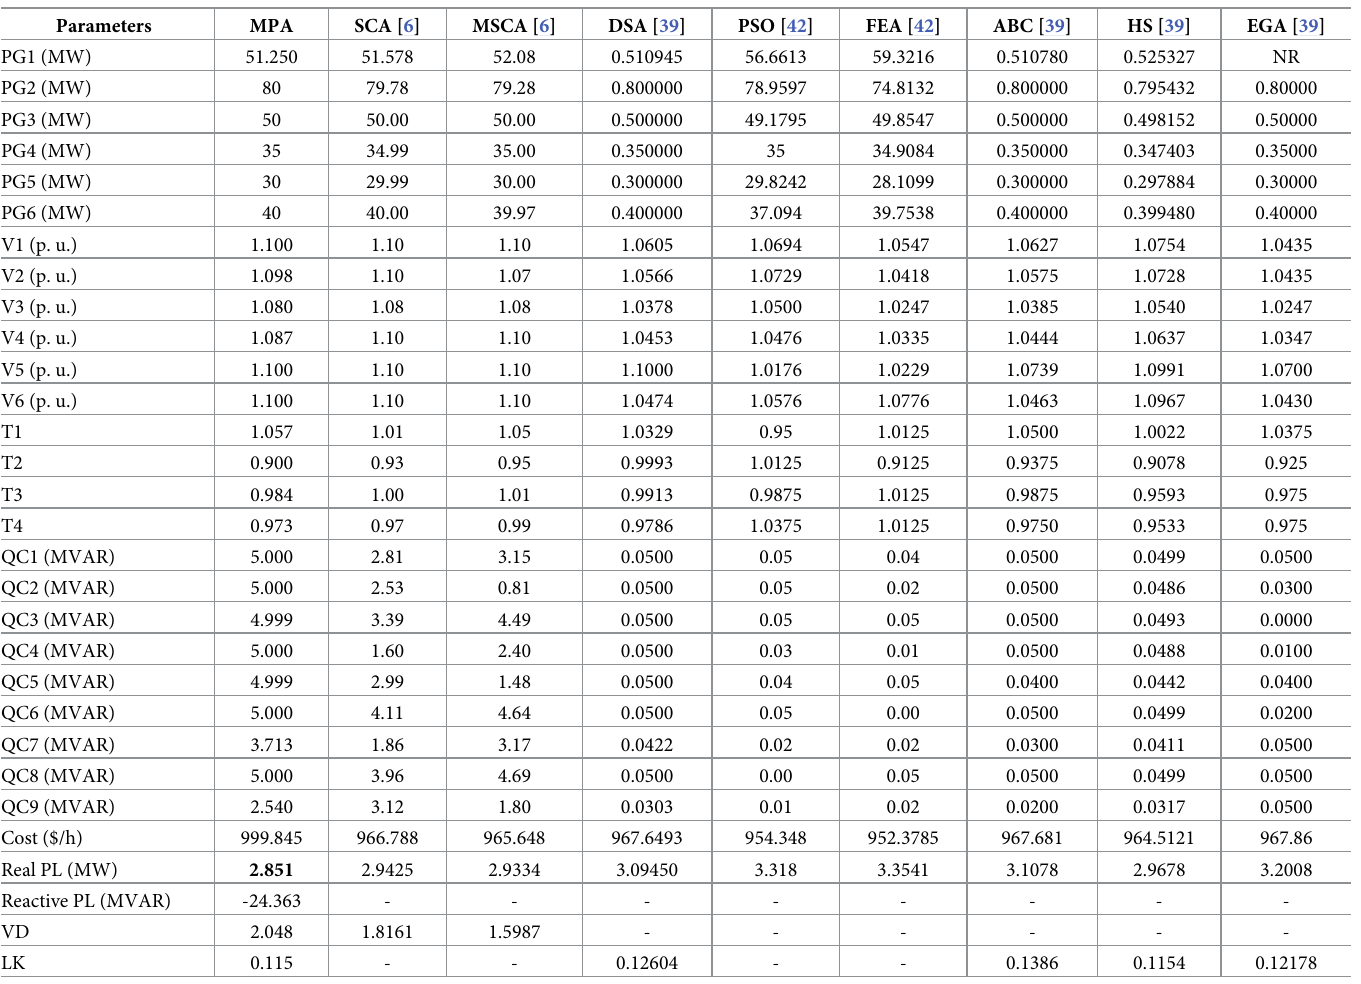
Table 3. Comparison of proposed algorithm with other literature work for case 2.